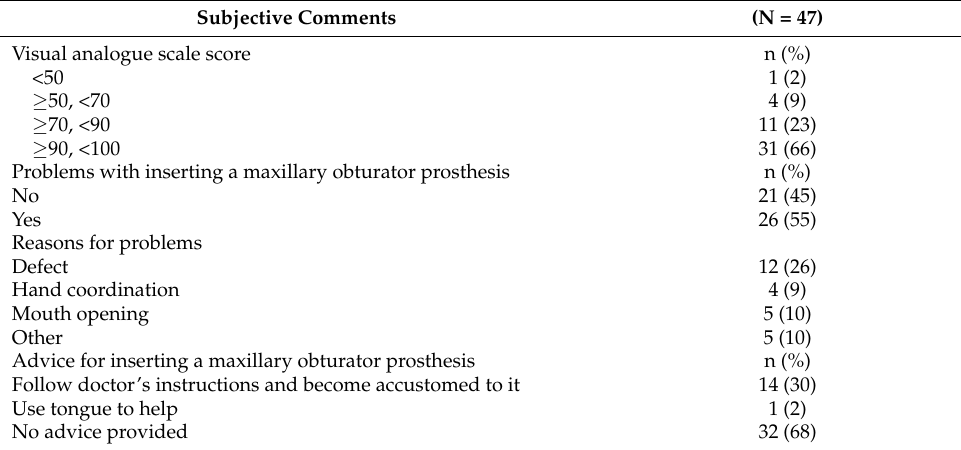
Table 4. Comments from the participants.